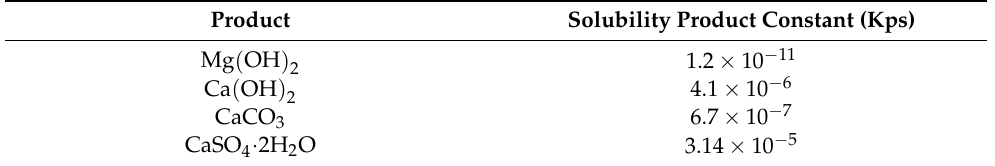
Table 1. Solubility constant of precipitates.